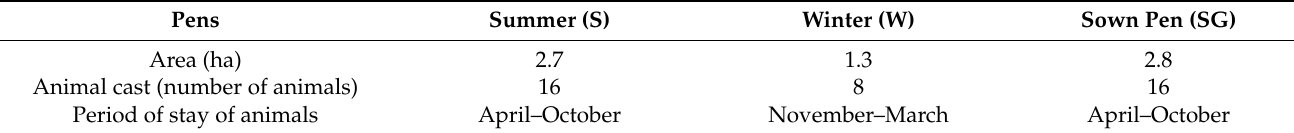
Table 1. Characteristics of research